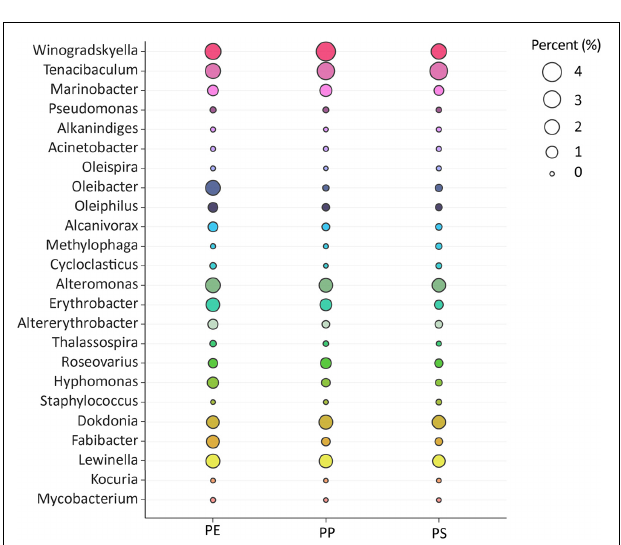
FIGURE 5 | Bacterial genera with members involved in hydrocarbon or oil degradation. Their abundance is presented per plastic type. Sizes of the circles represent rounded percentage of 16S rRNA gene sequence reads assigned to the different